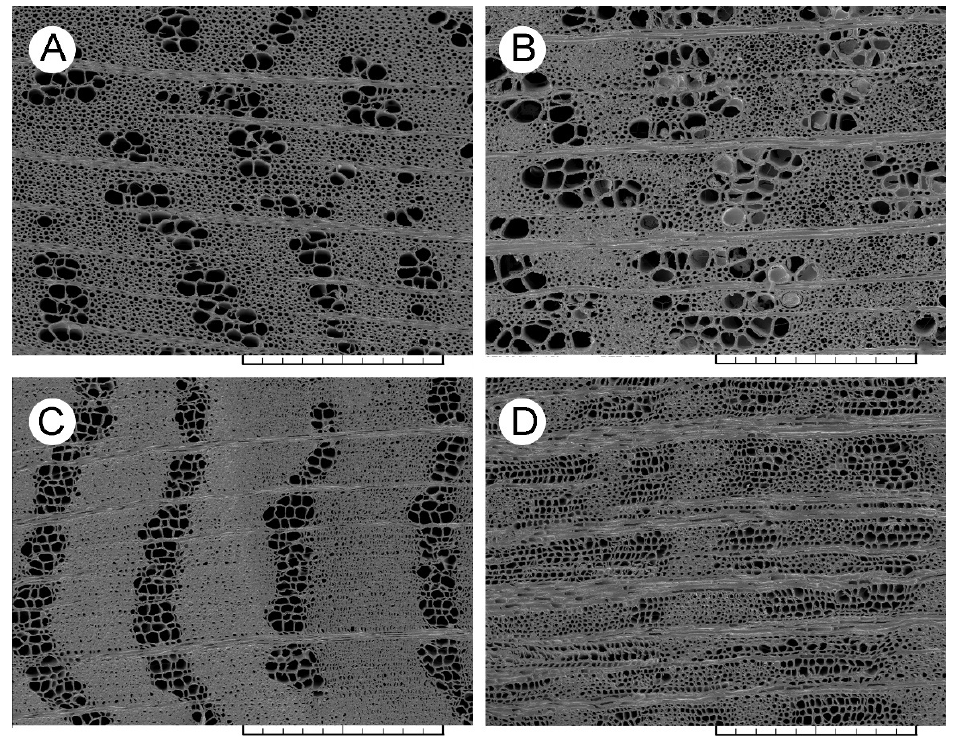
Figure 3. Scanning electron microscopy images of the latewood vascular architecture in the sixth annual growth ring of the examined Dutch elm hybrids. ( A ) The non-infected tree of ‘Groeneveld’. ( B ) The infected tree of ‘Groeneveld’. ( C ) The non-infected tree of ‘Dodoens’. ( D ) The infected tree of ‘Dodoens’. Cross-sections, scale bars ( A – D ) = 500 µm.